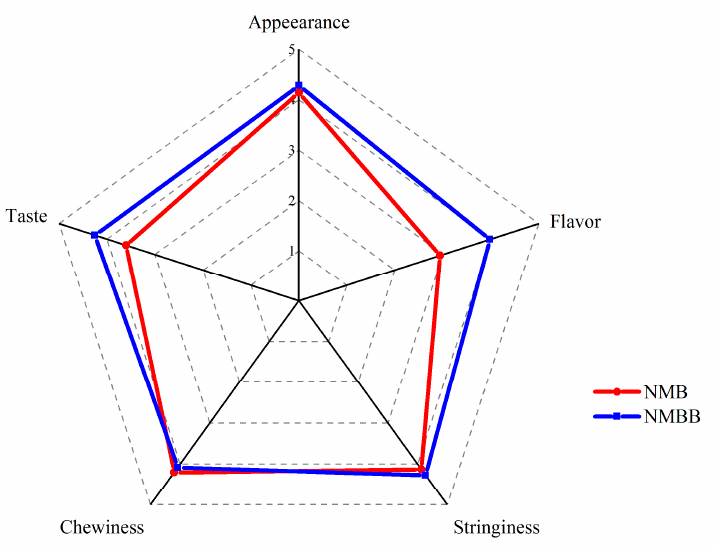
Figure 3. Net chart of sensory properties in natto fermented by two-strain (NMBB) and single-strain fermentation with GUTU09 (NMB).